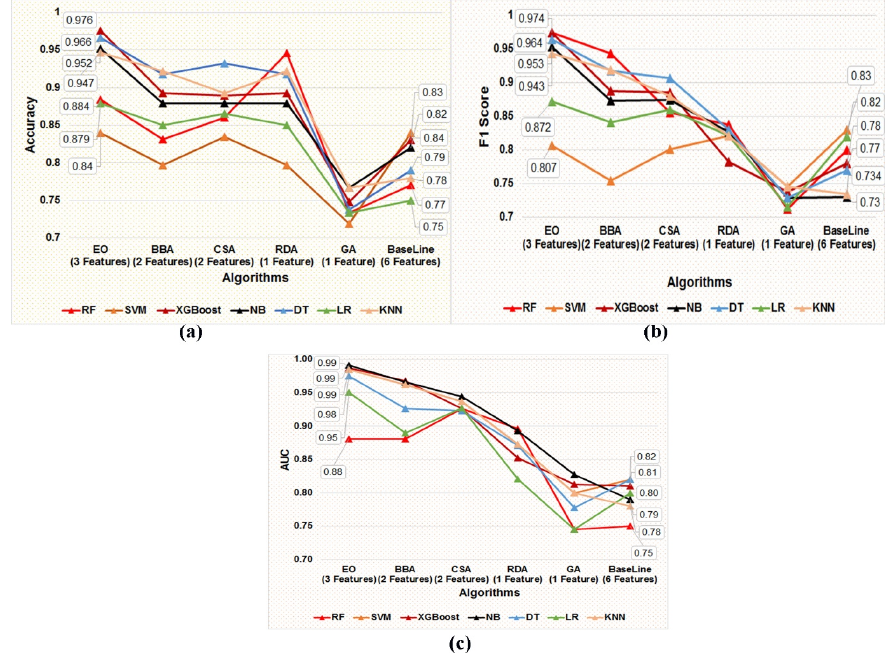
Figure 5. ( a – c ) Graphical representation of the comparative performance matrices, namely ( a ) accu- racy, ( b ) F1 score, and ( c ) AUC value of the seven classification models developed employing the five optimal subsets of feature(s) screened using five metaheuristic techniques, such as EO, BBA, CSA, RDA, and GA, respectively. Table 8. Tabulated results representing the comparative performance evaluation of the seven classifi- cation models developed using the five optimal subsets of feature(s) screened using five metaheuristic techniques, namely EO, BBA, CSA, RDA, and GA,